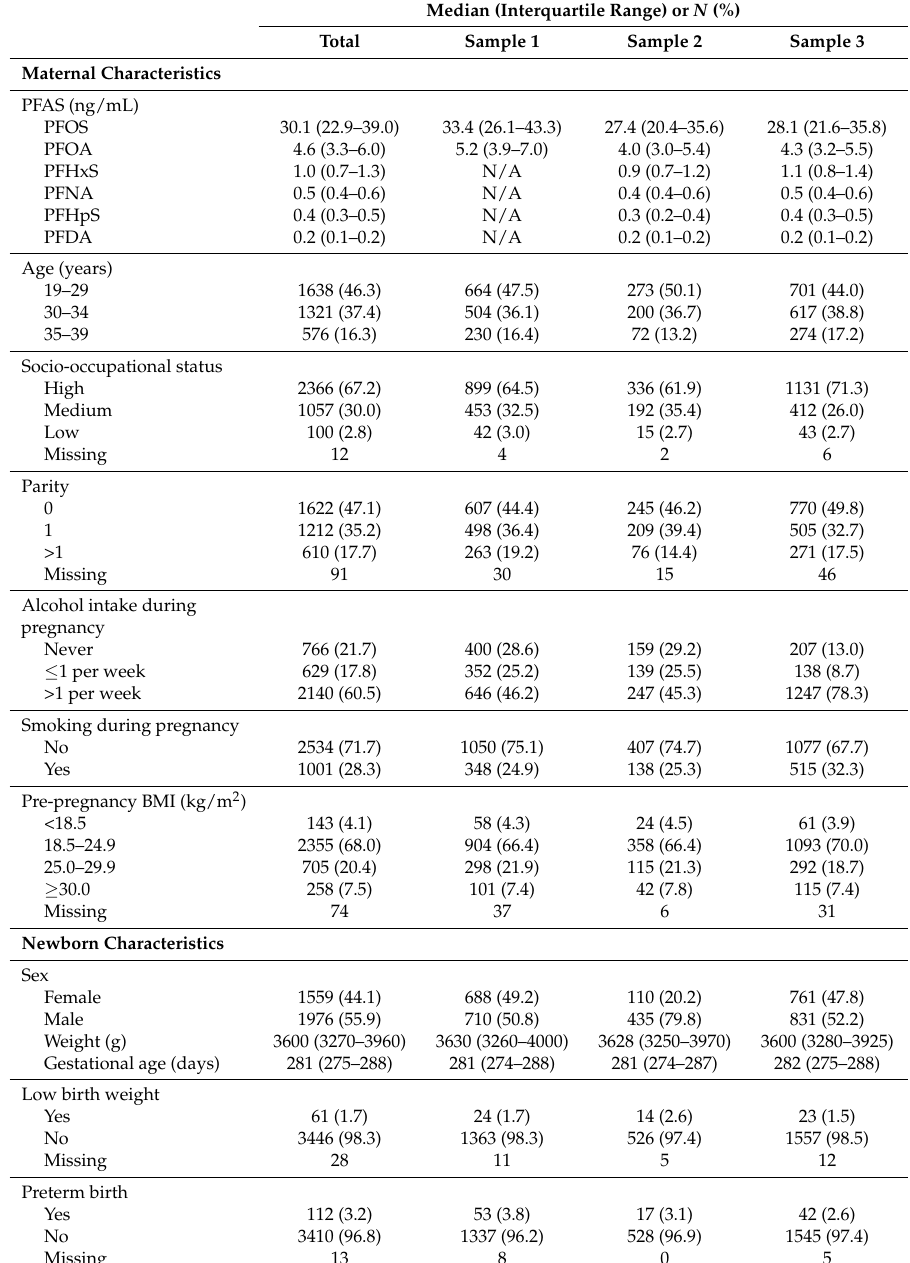
Table 1. Maternal and newborn characteristics of sub-study participants ( n = 3535) from the DNBC